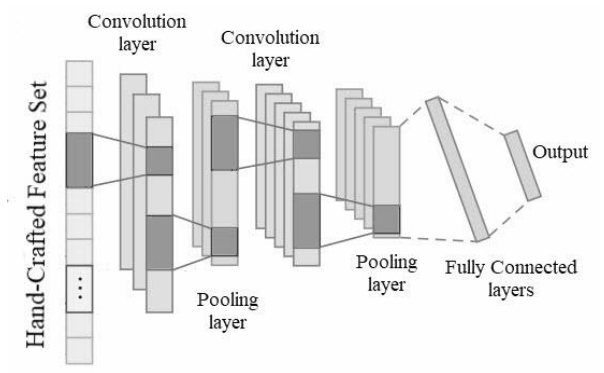
Fig. 2. The architecture of 1-D CNN.